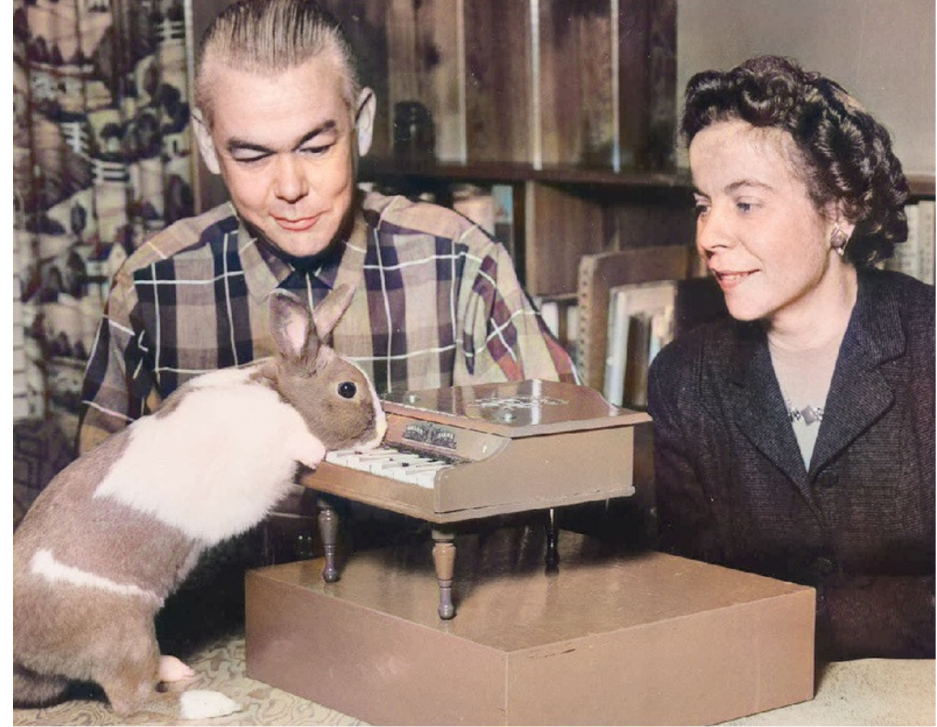
Figure 2. Colorized photo of Keller and Marian Breland training IQ Zoo’s Professor Punch, late 1950s. (Photo courtesy of Robert E.